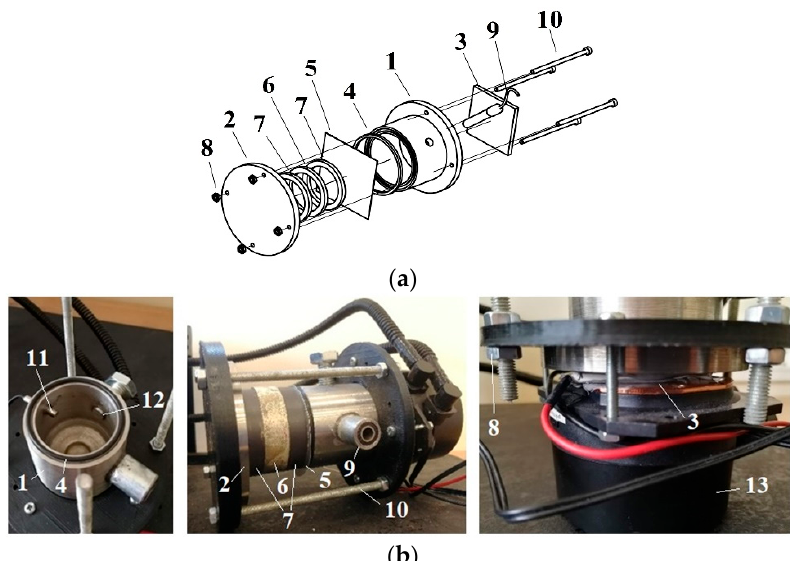
Figure 1. Electrochemical reactor for manufacturing AAO nanoporous membrane. ( a ) Drawing of the electrochemical reactor: 1: corps of the reactor, 2: cover of the reactor, 3: Peltier element, 4: gasket,